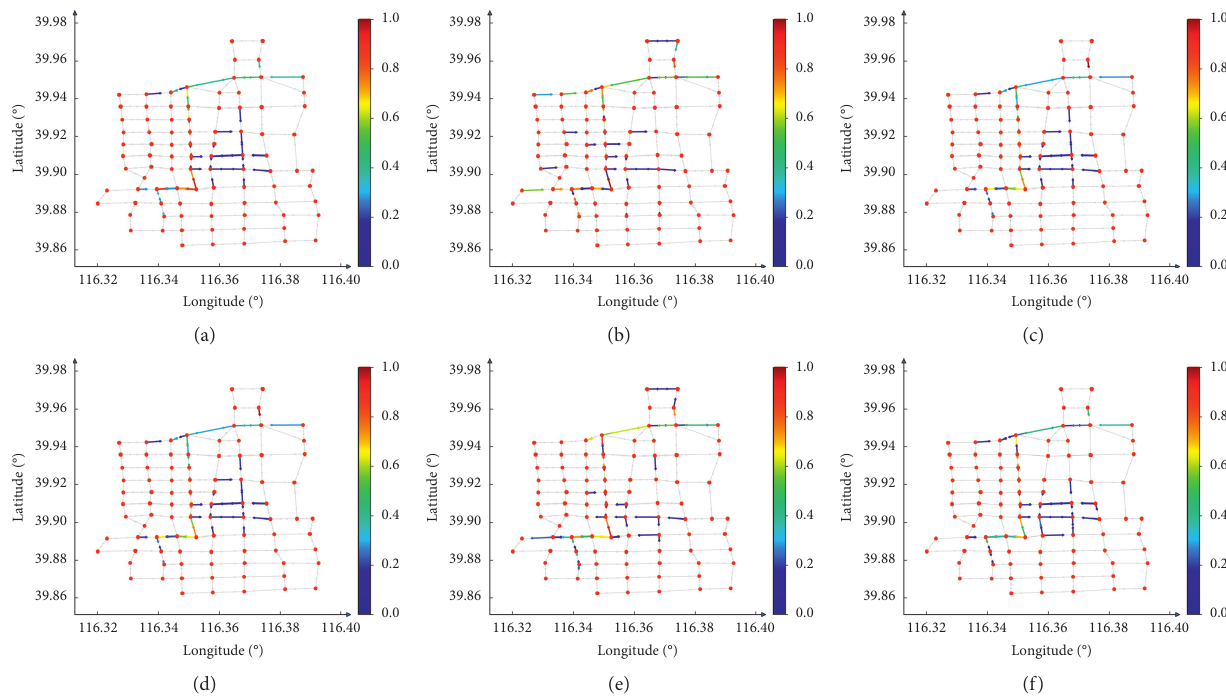
Figure 11: Distribution of the top 50 key roadway sections in different periods on Monday: (a) 6:00. (b) 8:00. (c) 12:00. (d) 14:00. (e) 17:00. (f) 22:00.